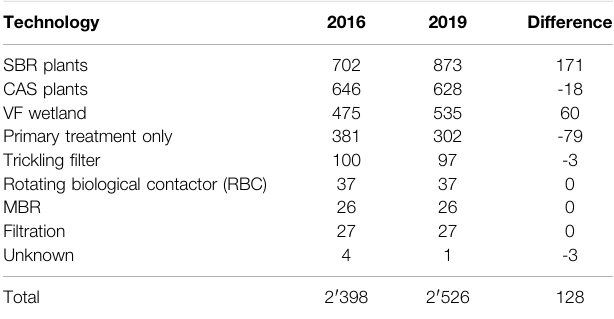
TABLE 1 | Number of small WWTPs in Upper Austria 2016 (Langergraber et al., 2018) and 2019 (Engstler, 2020). Technology